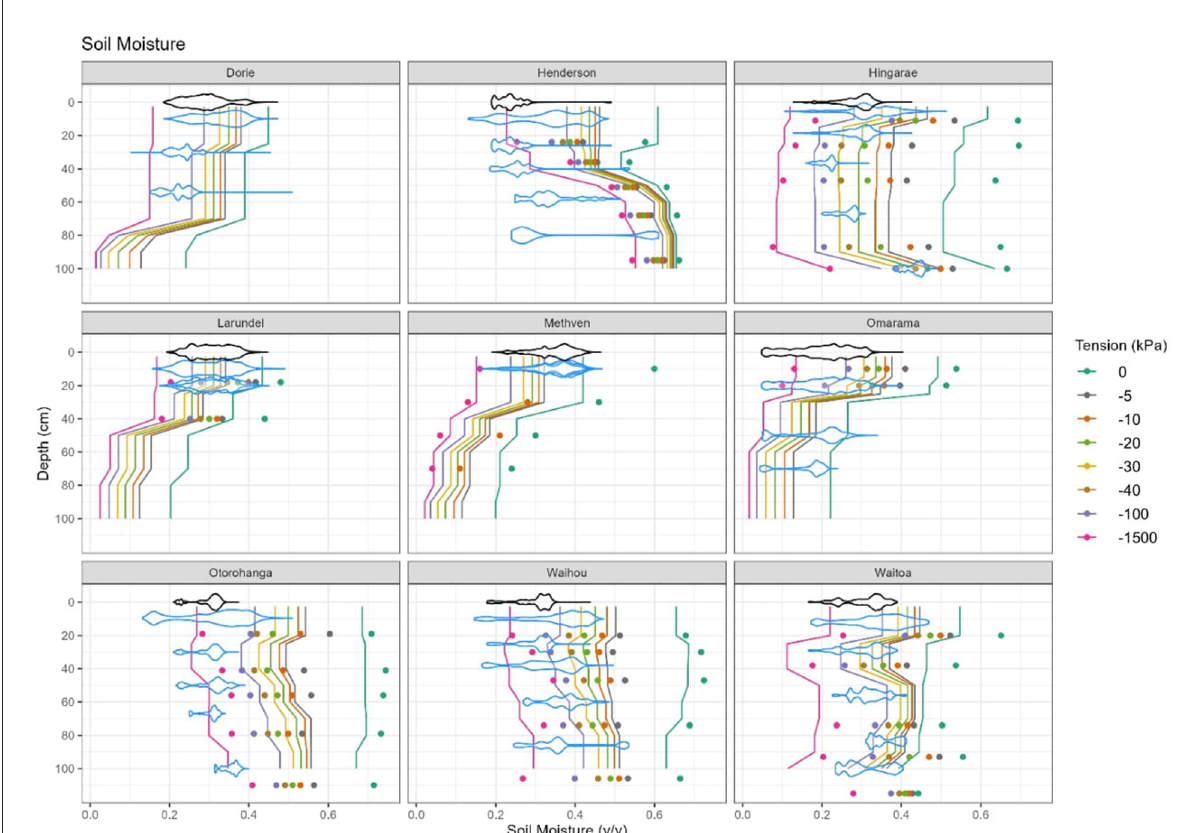
FIGURE5 Soil water content ranges with depth, comparing the uncalibrated soil water content probes (Figure 4, blue violin plots), with the S-map-hydro parameter database (lines), and laboratory measurements (dots). The black violin plots show the range of soil water content data used for model calibration, as described in the text.